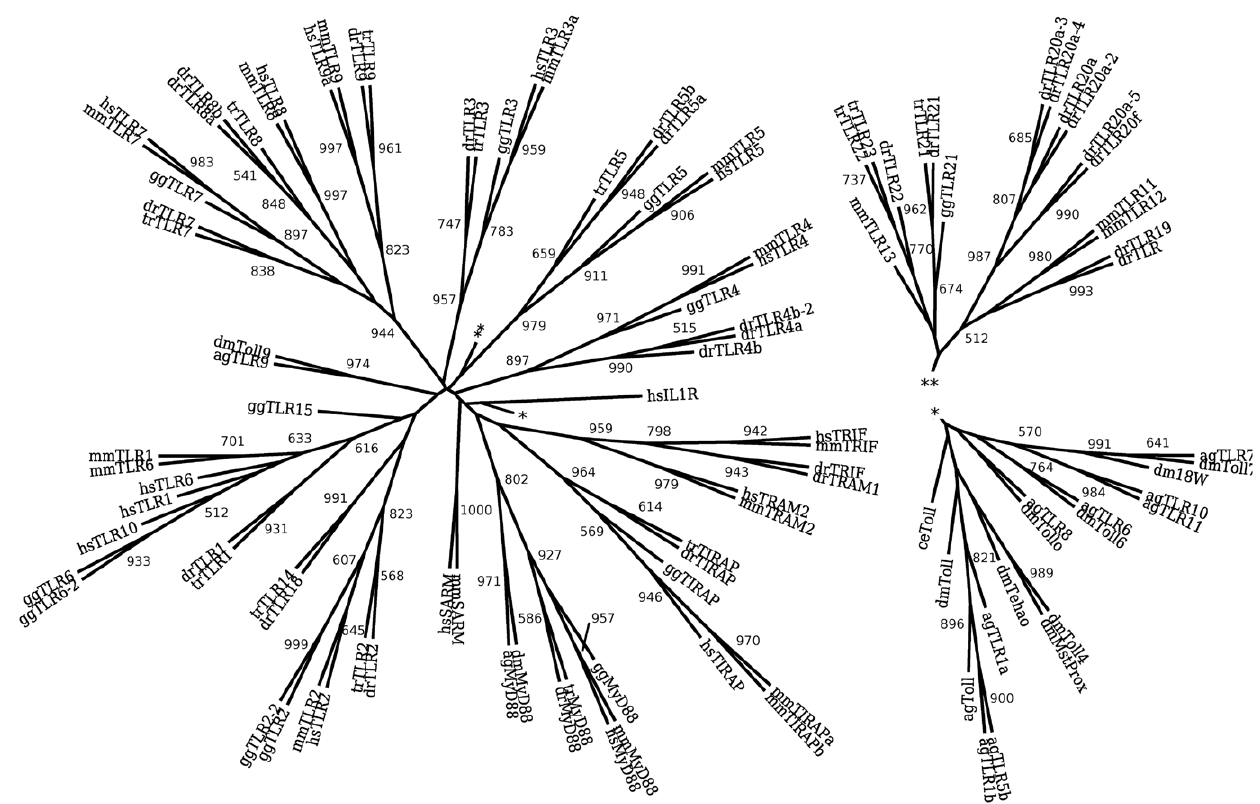
Figure 1. Maximum likelihood phylogeny of the TIR domain of the TLR family and TLR adaptor molecules shows strong support for individual branches corresponding to vertebrate TLR3, TLR4, TLR5, and invertebrate TLR9. Additionally, the invertebrate TLR9 taxa cluster with vertebrate TLRs outside of the main invertebrate TLR branch. A single cluster contains both vertebrate and invertebrate MyD88, but other TLR adaptor molecules form three groups: TIRAP, SARM; and a single branch for both TRIF and TRAM. The tree is rooted by the outgroup TIR domain Homo sapiens interleukin 1 receptor. The numbers indicate boot-strap support out of 1000. Only values above 500 are indicated.